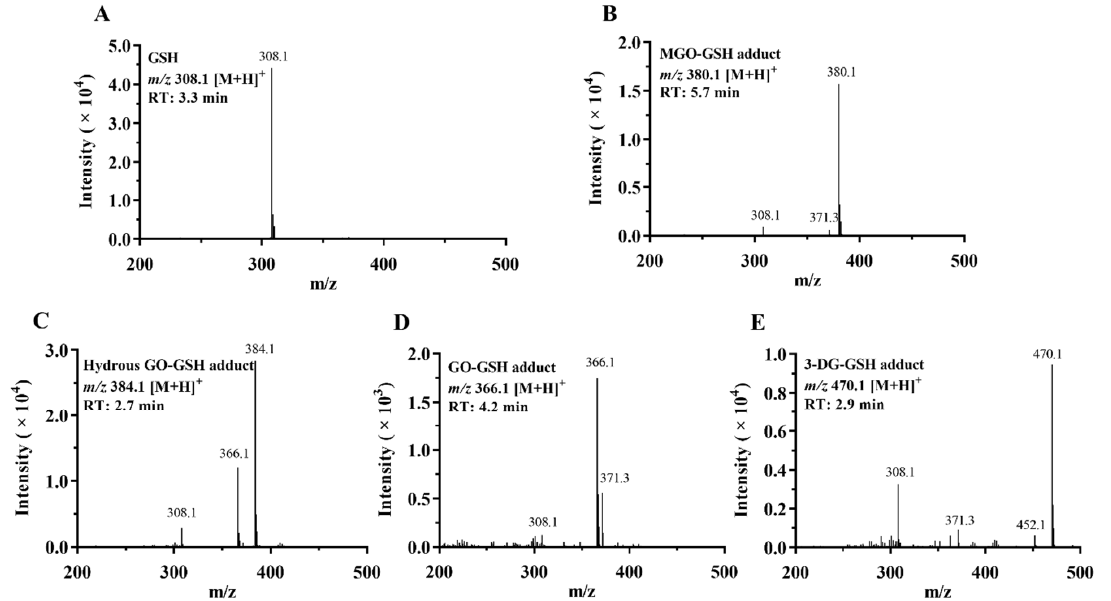
Figure 3. LC-TOF-MS spectra of GSH ( A ), MGO-GSH adduct ( B ), hydrous GO-GSH adduct ( C ), GO-GSH adduct ( D ), and 3-DG-GSH adduct ( E ).